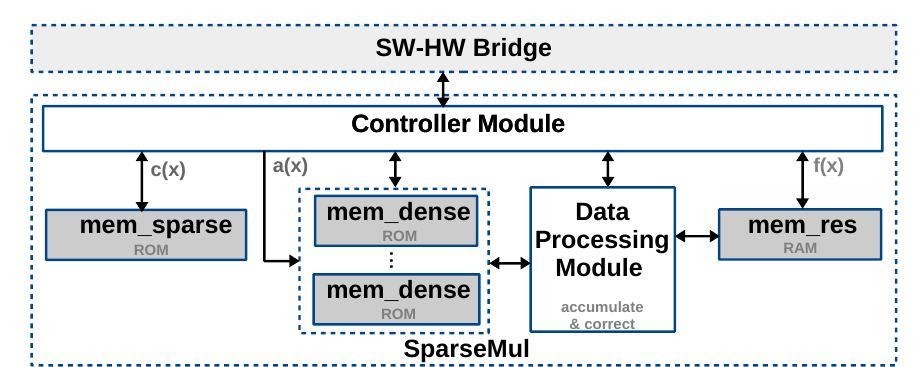
Figure 5: Dataflow diagram of the SparseMul hardware